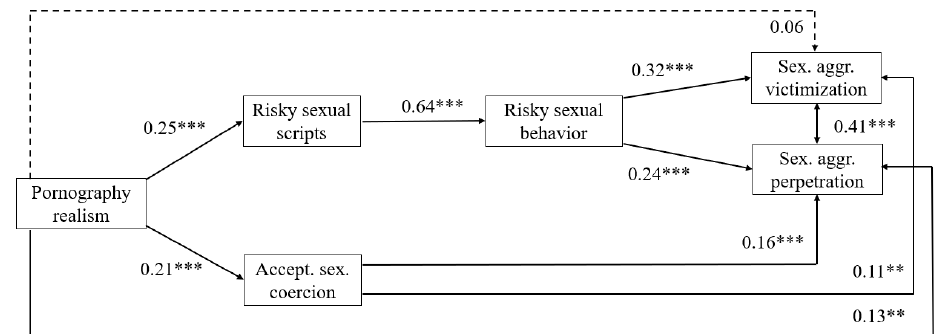
Figure 1. Path model linking pornography realism to sexual aggression (standardized coefficients).